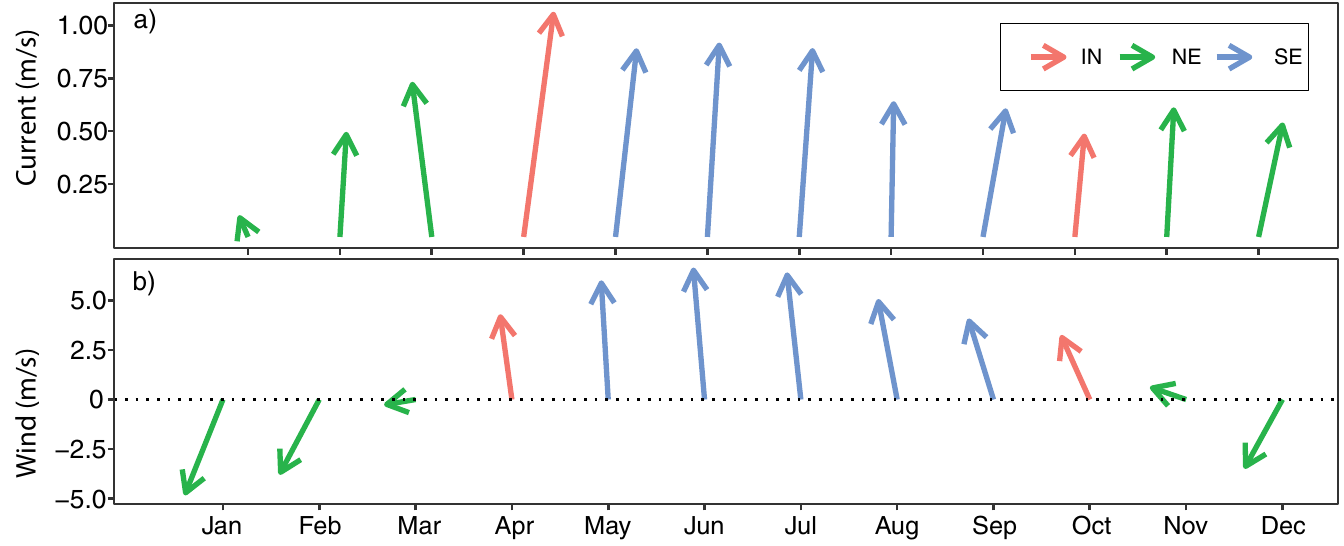
Fig 14. Climatological median of a) surface current speed from drifter observations and b) wind speed from QuikSCAT in the Pemba Channel.